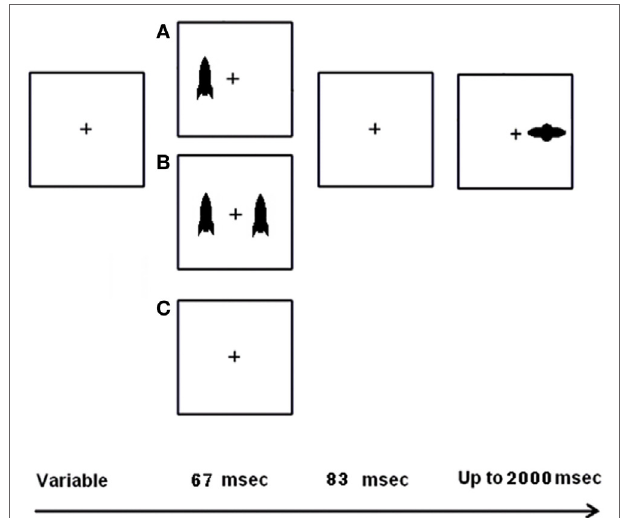
FigUre 1 | Schematic of the child spatial cueing (SC) task. A fixation cross appeared for a variable period (600–3,000 ms). Afterward, one, two, or no cues appeared for 67 ms followed by a gap of 83 ms. Once the target appeared, it remained on display until a left or right key press was made or until 2,000 ms had elapsed